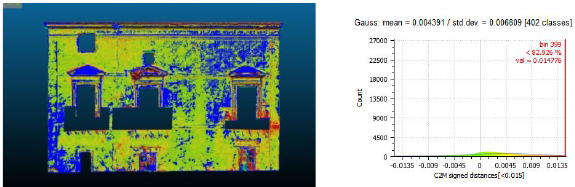
Figure 11. Comparison between the south-east photogrammetric mesh and TLS point cloud.